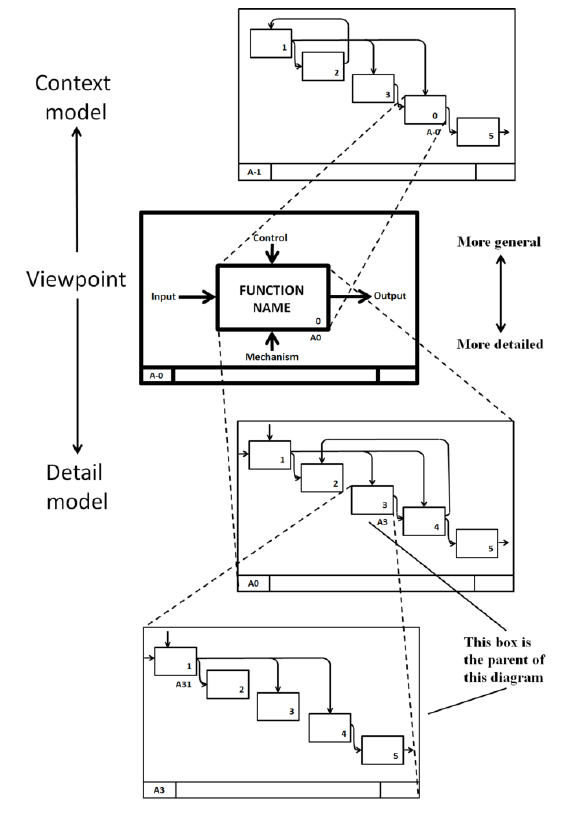
Figure 4. An illustration of diagram levels (A-1, A-0, A0, etc. ) and the detailing procedure in IDEF0 function modeling. From NIST